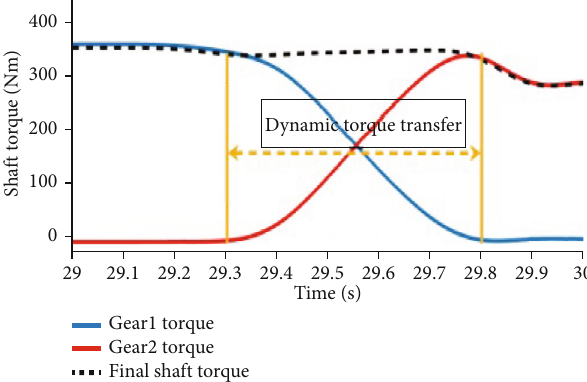
Figure 4: Torque comparison -2.